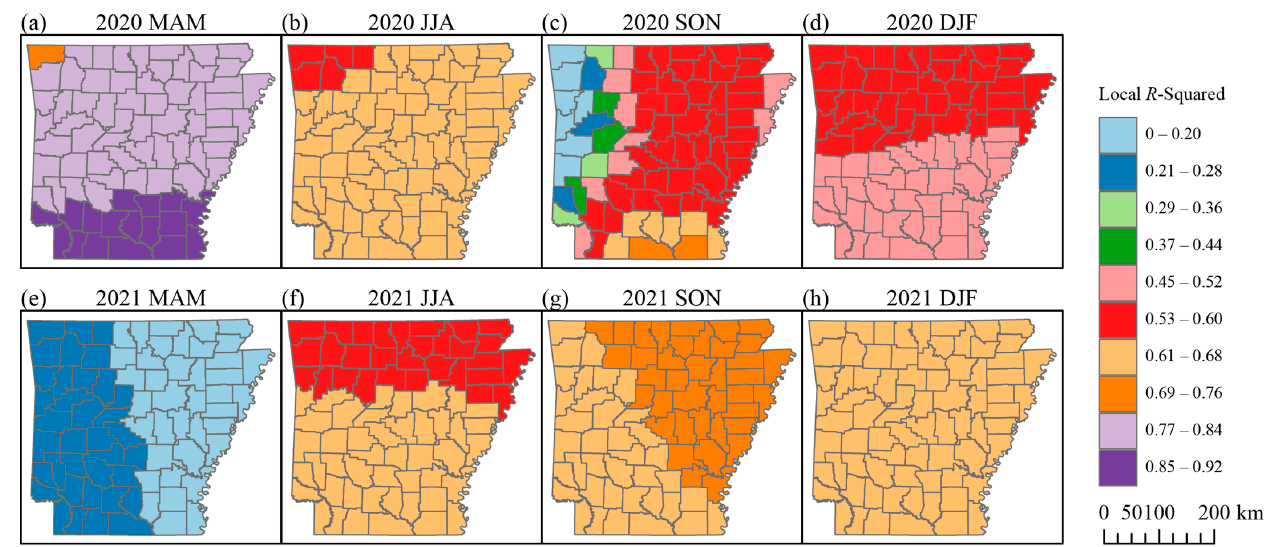
Figure 4. The local R -squared values for the GWR models in each season from 2020 to 2021.